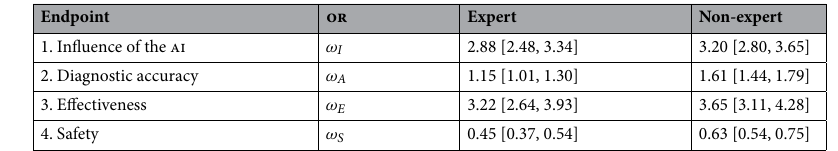
Table 5. Odds-ratios (or) for each endpoint, estimated separately for experts and non experts. We report in brackets the 95% confidence intervals.